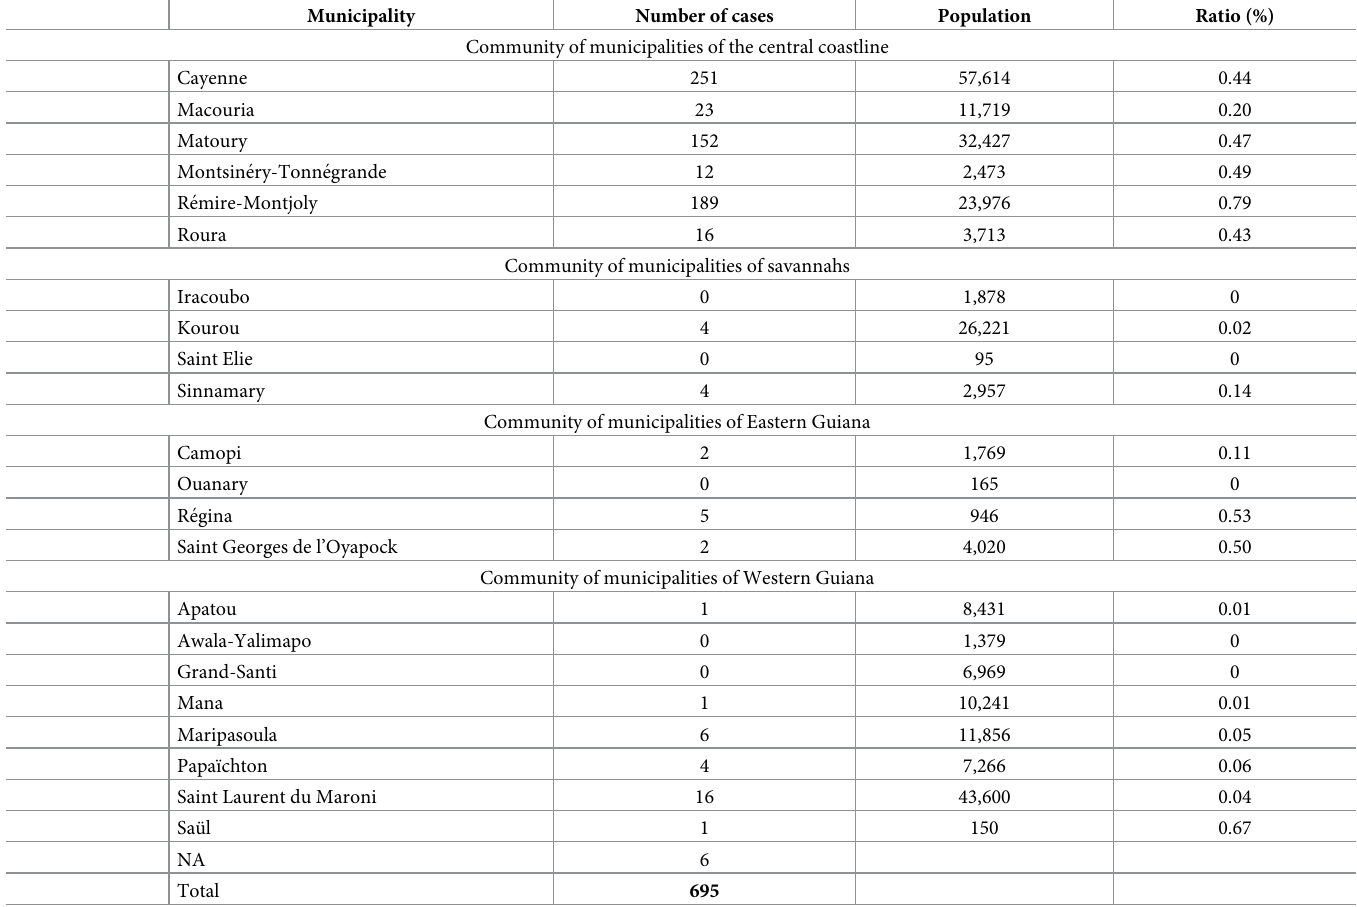
Table 1. Number of cases on the 2007–2017 and compared to the population of each municipality.